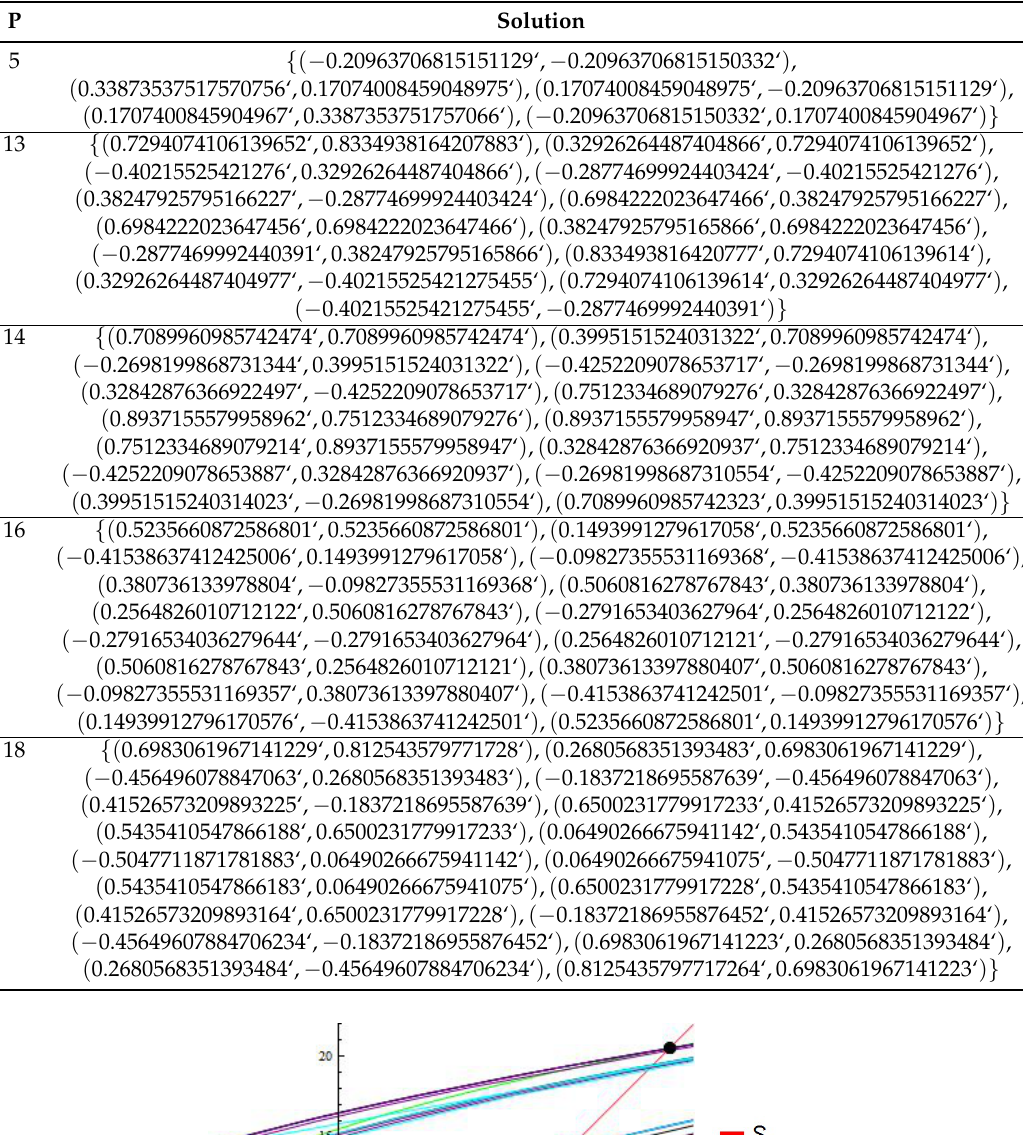
Table 1. List of periodical solutions of the period 5,13,14,16 and 18 for α = 0.5, β = 1.5.